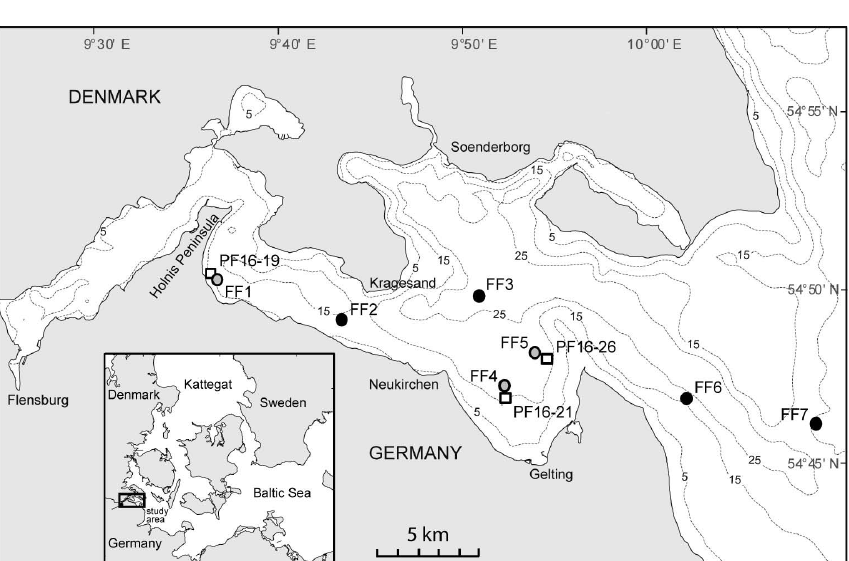
Fig. 1. Map of study area of Flensburg Fjord (design by courtesy of Anna Nikulina, GEOMAR). Insert indicates the location of study area within the SW Baltic Sea. Circles display sediment corer (FF1, FF4 and FF5) and water chemistry stations (FF1–FF7). White squares